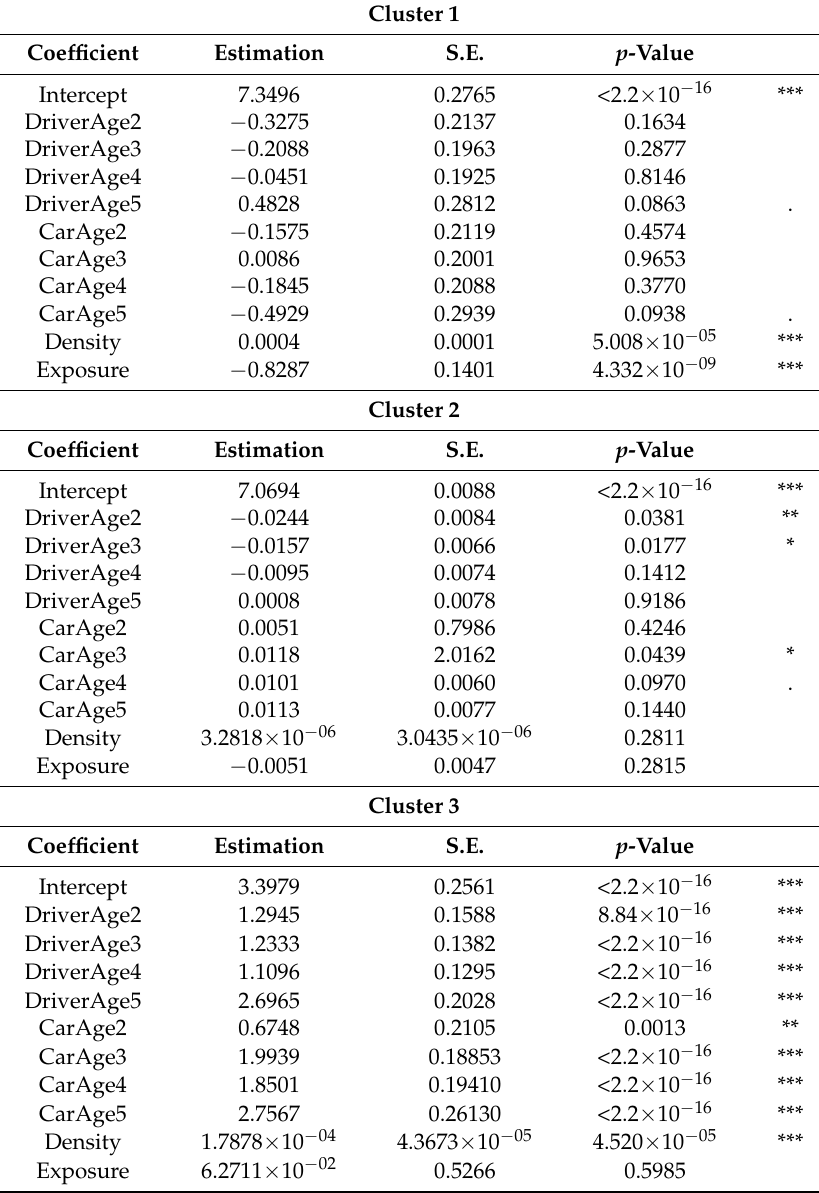
Table A2. Results for the CWM model. The significance of the p-values are shown with the corresponding level of significance as defined ≈ 0 (***), 0.001 (**), 0.01 (*), and 0.05 (.) for each estimated